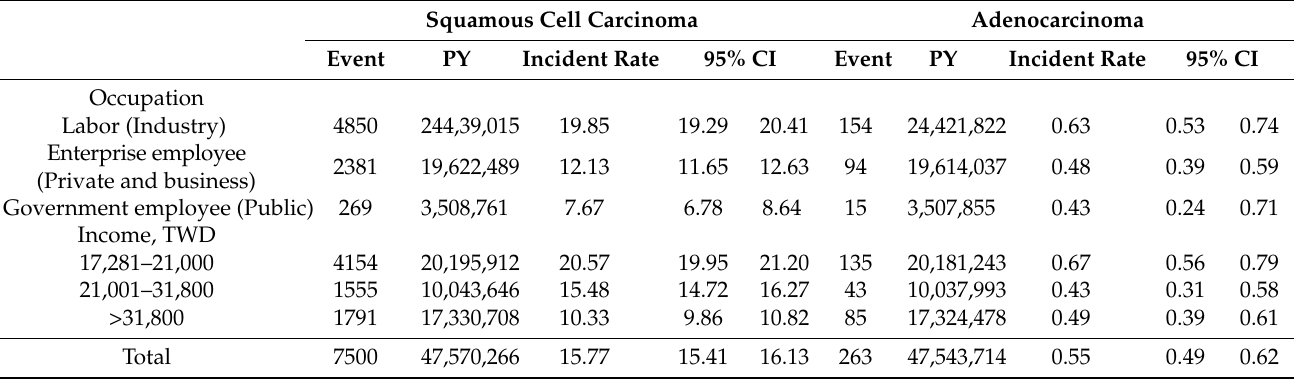
Table 2. Incidence rate (per 100,000 person-years) of esophagus cancer in Taiwan, 2008–2014. Squamous Cell